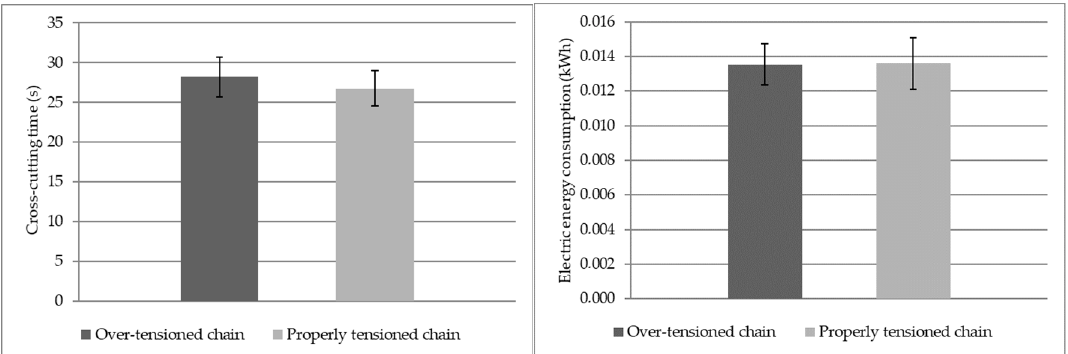
Figure 1. ( a ) Cross-cutting time consumption by chain tension adjustment—mean and 95% confidence interval ( b ) Electric energy consumption by chain tension adjustment—mean and 95% confidence interval.